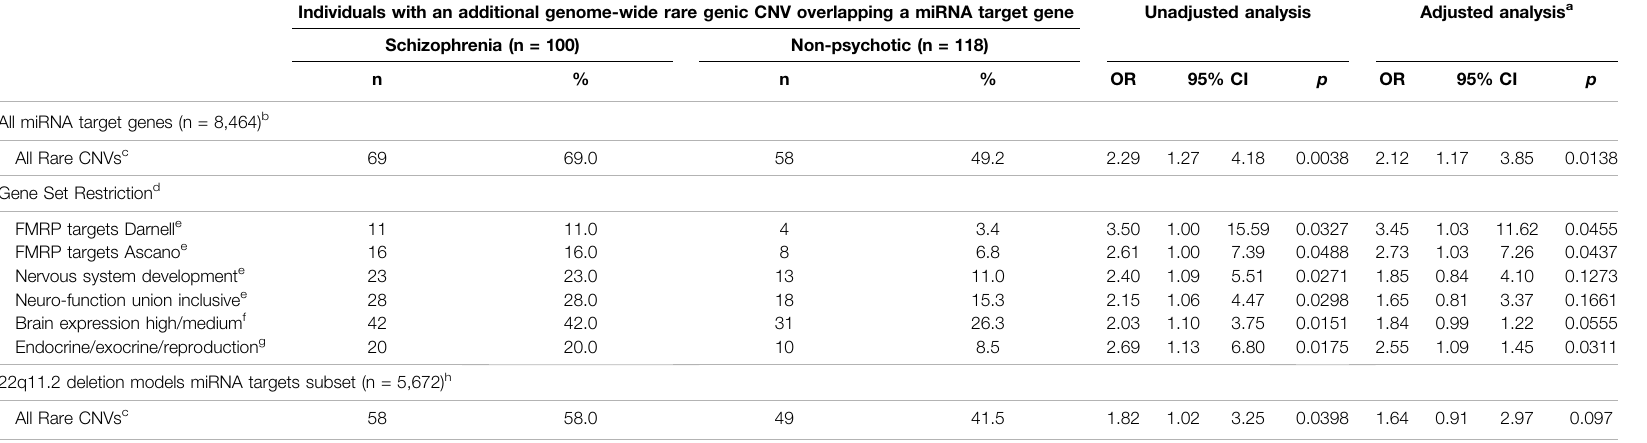
TABLE 1 | Schizophrenia expression in 22q11.2DS and its relationship to having a miRNA target gene overlapped by an additional rare CNV. Individuals with an additional genome-wide rare genic CNV overlapping a miRNA target gene Unadjusted analysis Adjusted analysis